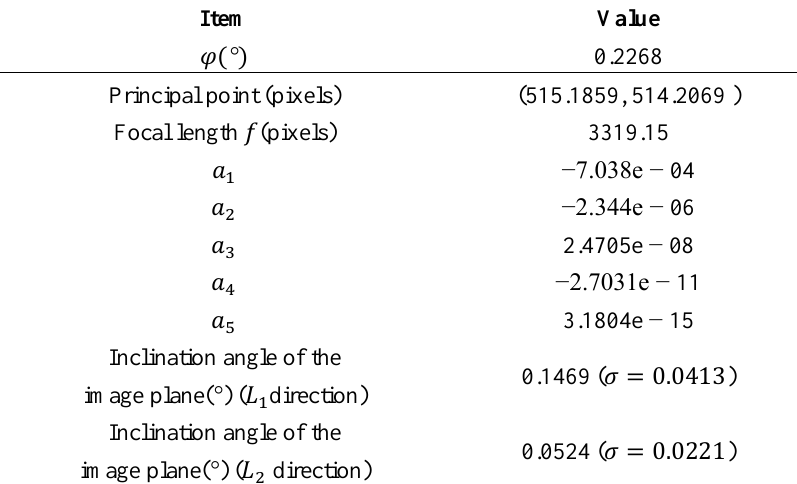
Table 3. Calibration result.